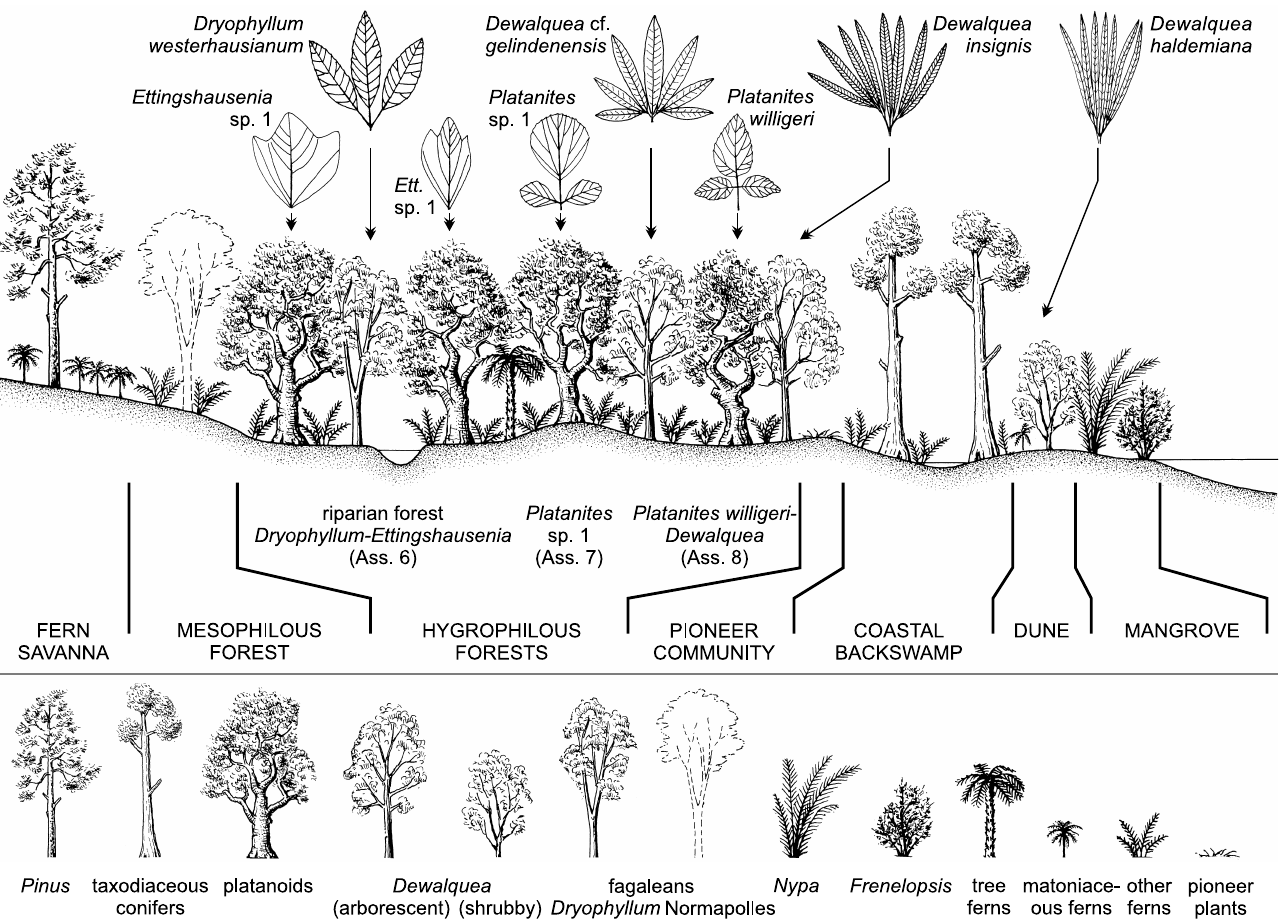
Fig. 21. Hypothetical reconstruction of vegetal palaeocommunities in the Coniacian–Santonian of Lower Silesia (palaeocatena sensu Krassilov 2003: 65). Among fagaleans, hygrophilous Dryophyllum preserved in the megafossil record (pollen unknown, even if possibly belonging to the Normapolles group) is distinguished from presumably mesophilous Normapolles trees known only from the microfossil record (dashed line, megafossils unknown). See text for further explanations. Drawings by Bogusław Waksmundzki. Abbreviations: Ass., Assemblage; Ett. , Ettingshausenia